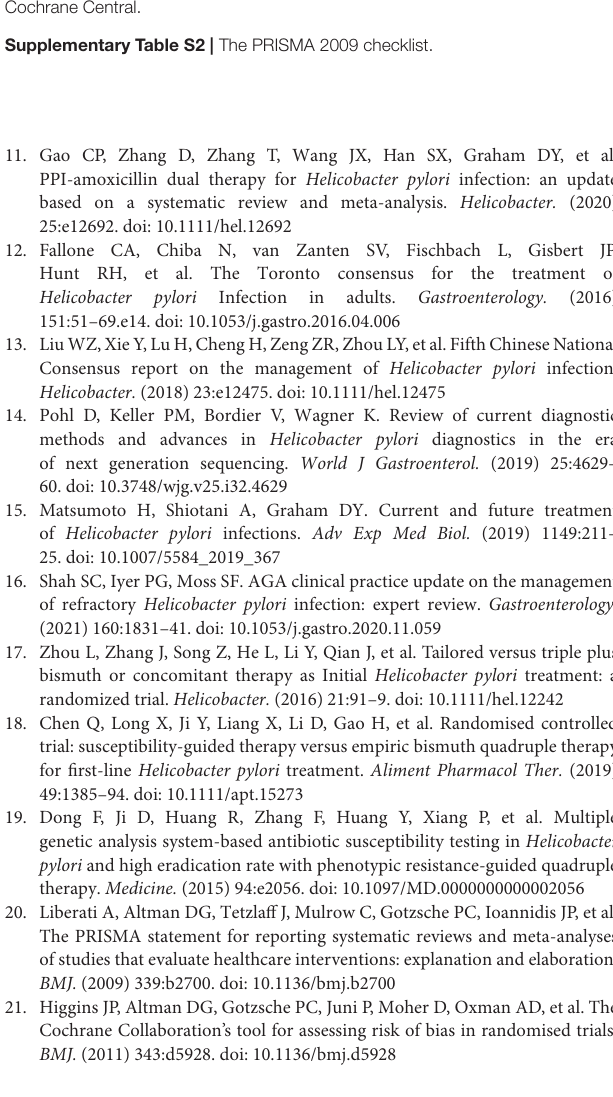
Supplementary Figure S6 | Forest plots for the pooled eradication rate of bismuth-containing quadruple therapy (BQT) by an ITT analysis. Supplementary Figure S7 | Forest plots for the pooled eradication rate of SGT by per-protocol (PP) analysis. Supplementary Figure S8 | Forest plots for the pooled eradication rate of BQT by PP analysis. Supplementary Figure S9 | Forest plots for the comparison of SGT vs. BQT by different treatment duration in Helicobacter pylori eradication. Supplementary Figure S10 | Forest plots for the comparison of SGT vs. BQT by different antibiotic combinations in H. pylori eradication. Supplementary Figure S11 | Forest plots for the pooled side effect rate of SGT. Supplementary Figure S12 | Forest plots for the pooled BQT side effect rate. Supplementary Figure S13 | Forest plots for the pooled compliance of SGT. Supplementary Figure S14 | Forest plots for the pooled compliance of BQT. Supplementary Table S1 | Full search strategy in PubMed, Embase, and Cochrane Central. Supplementary Table S2 | The PRISMA 2009